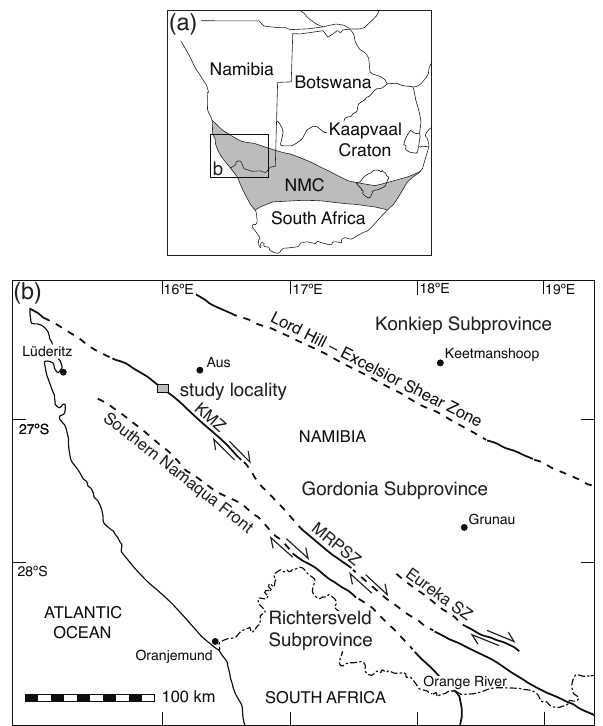
Figure 1. Geological setting of the study area. (a) Map of southern Africa showing the extent of the Namaqua Metamorphic Complex (NMC). (b) Location of the study area to the south-west of Aus in southern Namibia. The Kuckaus Mylonite Zone (KMZ) forms part of the larger Marshall Rocks–Pofadder shear zone (MRPSZ) and has a similar orientation, kinematics and age as the south- ern Namaqua Front that separates the Richtersveld and Gordonia subprovinces of the NMC and the Lord Hill–Excelsior shear zone that separates the Gordonia and Konkiep subprovinces. After Miller (2008) and Macey et al.